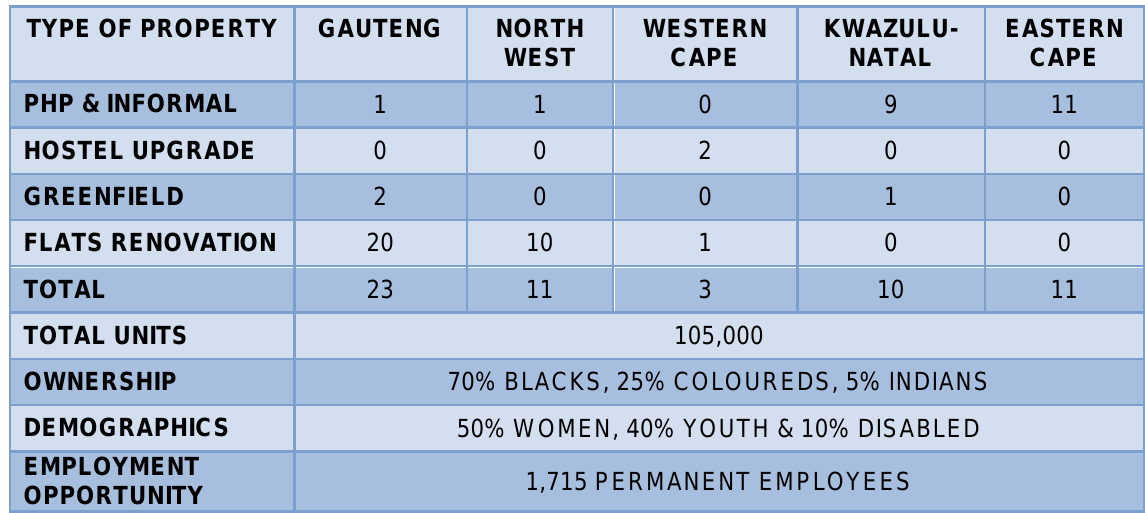
Table 1 National Co-operative Housing Membership Statistics in Five Provinces Source: Matsela, 2010; presentation on housing co-operatives to the National Housing Portfolio Committee Parliament, Cape